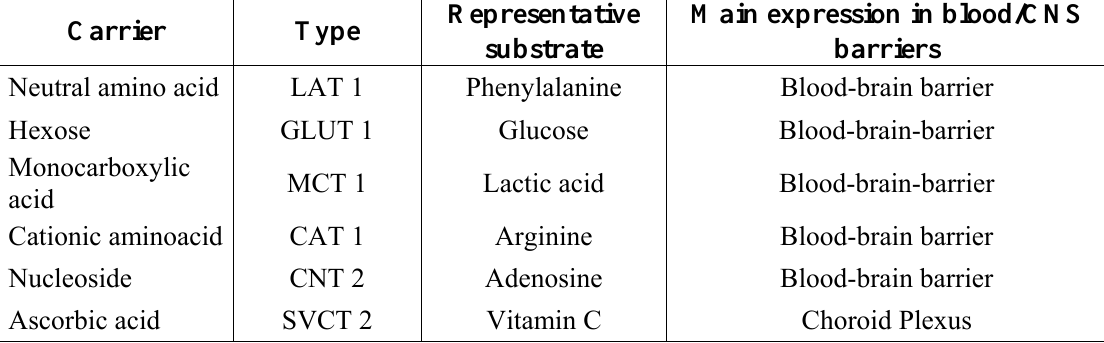
Table 1. CMT systems involved in the transport of nutrients into the central nervous system.